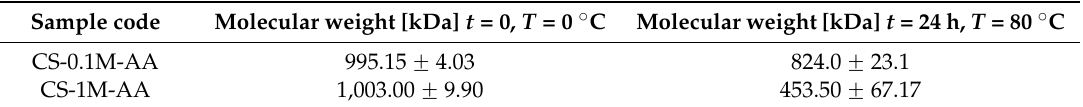
Table 2. Molecular weights, with respective standard deviations, for the indicated samples at initial and final time instants at 80 °C. and final time instants at 80 ˝ C.